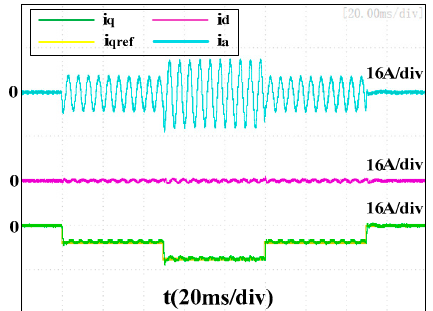
Figure 17. d-q axis current waveform of the current controller without decoupling at 12,000 rpm with Kp = 500 π Ls. Figure 18. d-q axis current waveform of the current controller with feedback decoupling at 12,000 rpm with Kp = 500 π Ls.